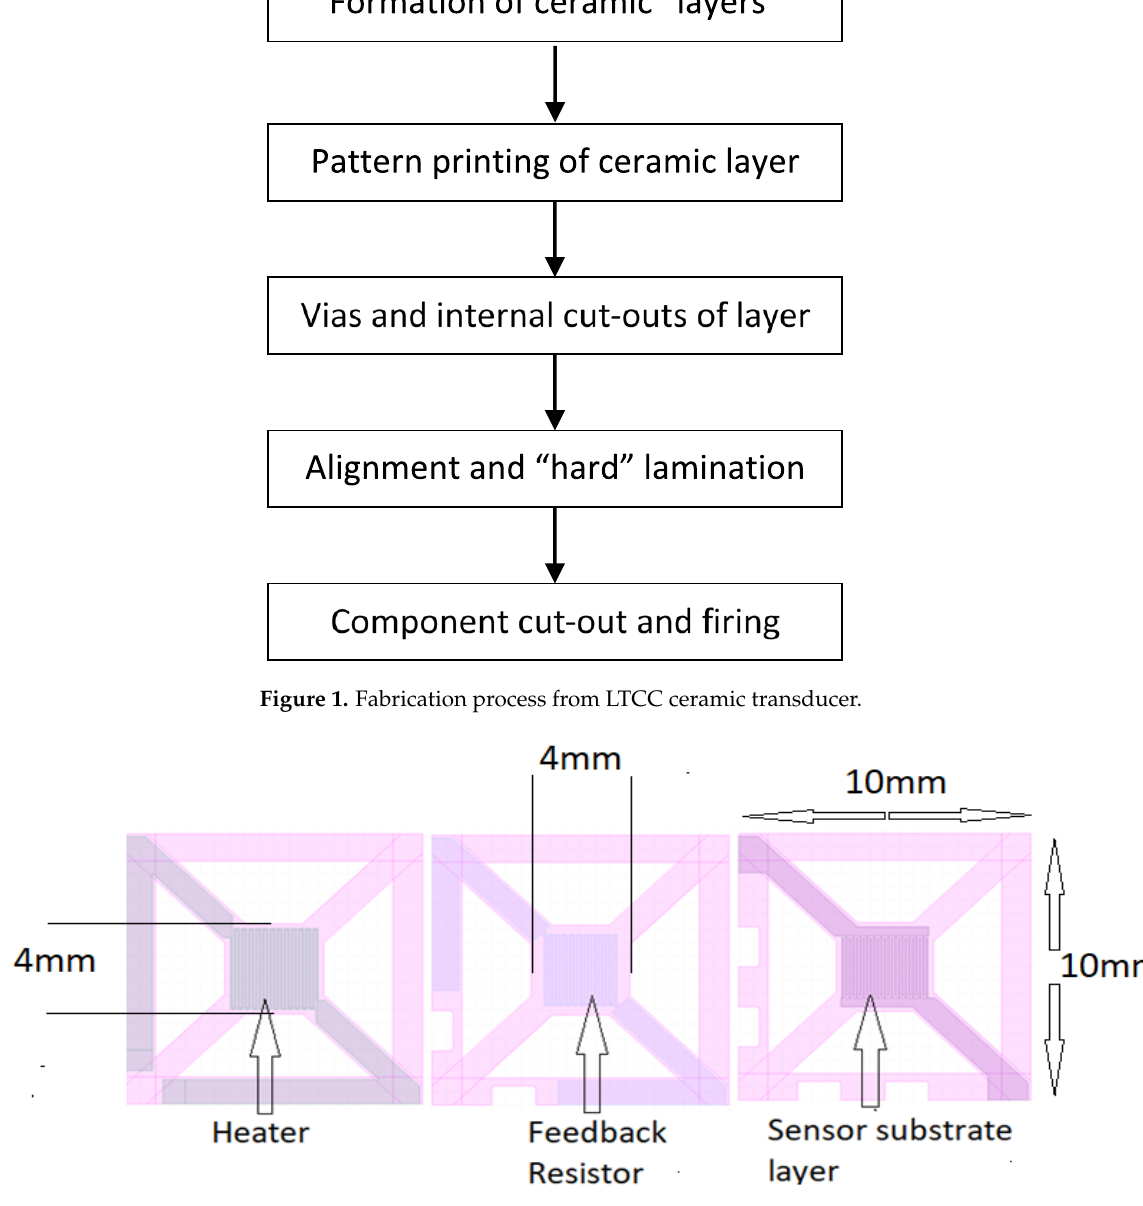
Figure 2. Sensor design.